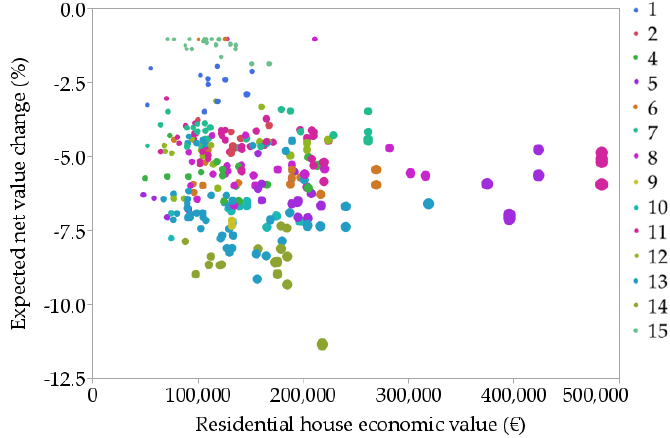
Figure 11. Wildfire risk bubble plot of residential houses in the study area. The expected net value change (eNVC) is the percentage variation with respect to the price of the residential houses. The bubble size indicates the expected economic loss (eEL), which ranged from a low of 3622€ to a high of 28,086€. The color indicates the council. Table 6. Council level summary table with expected economic loss (eEL) results for the